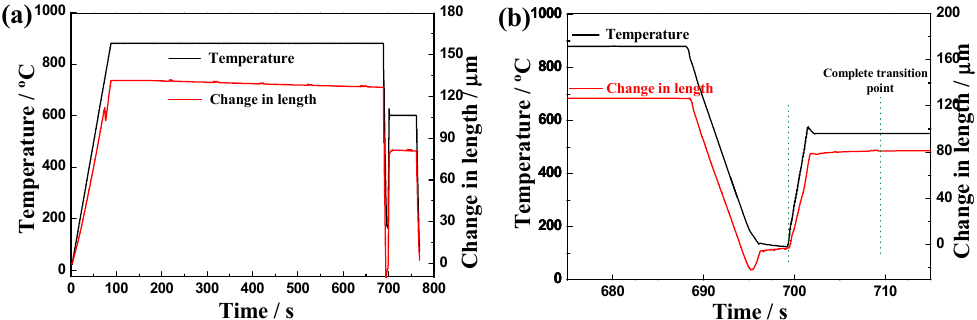
Figure 10. ( a ) Real time–temperature–expansion curve of the heating process for samples pre-quenched at 120 °C and tempered at 600 °C; ( b ) local curves for “temperature” and “change in length” transformation.